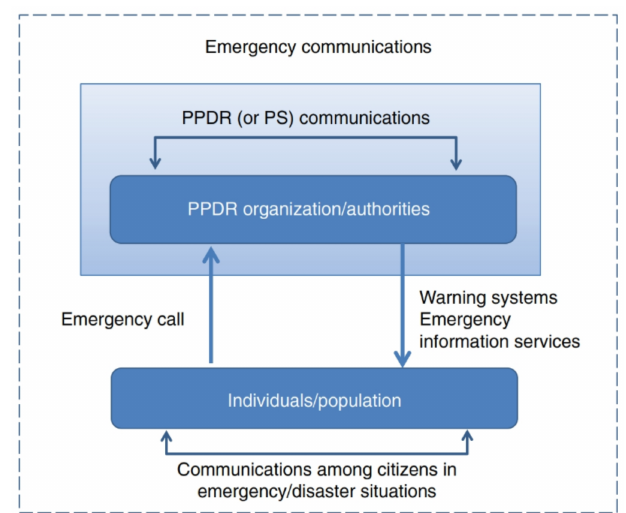
Figure 2. Scope of Public Protection and Disaster Relief (PPDR) and emergency